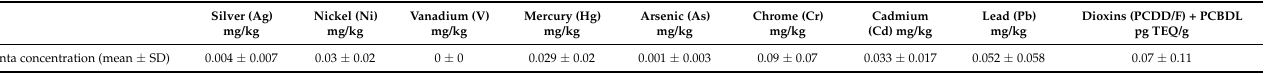
Table 6. Metals and dioxin/PCBDL placenta concentrations expressed as mean ± standard deviation (SD). Silver(Ag) Nickel(Ni) Vanadium(V) Mercury(Hg) Arsenic(As) mg/kg mg/kg mg/kg mg/kg